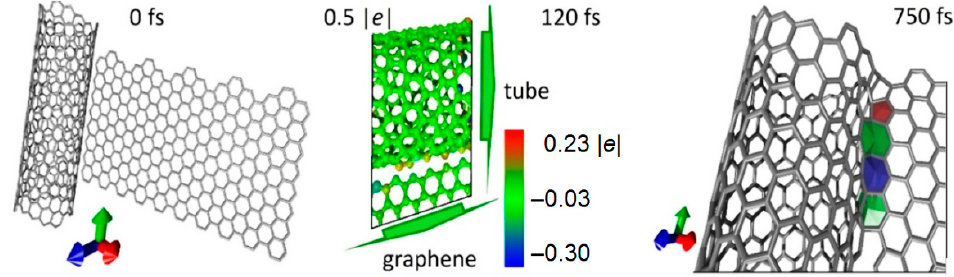
Figure 4. Nanowelding of nanotube (14,4) and graphene sheet at different positions of graphene sheet.